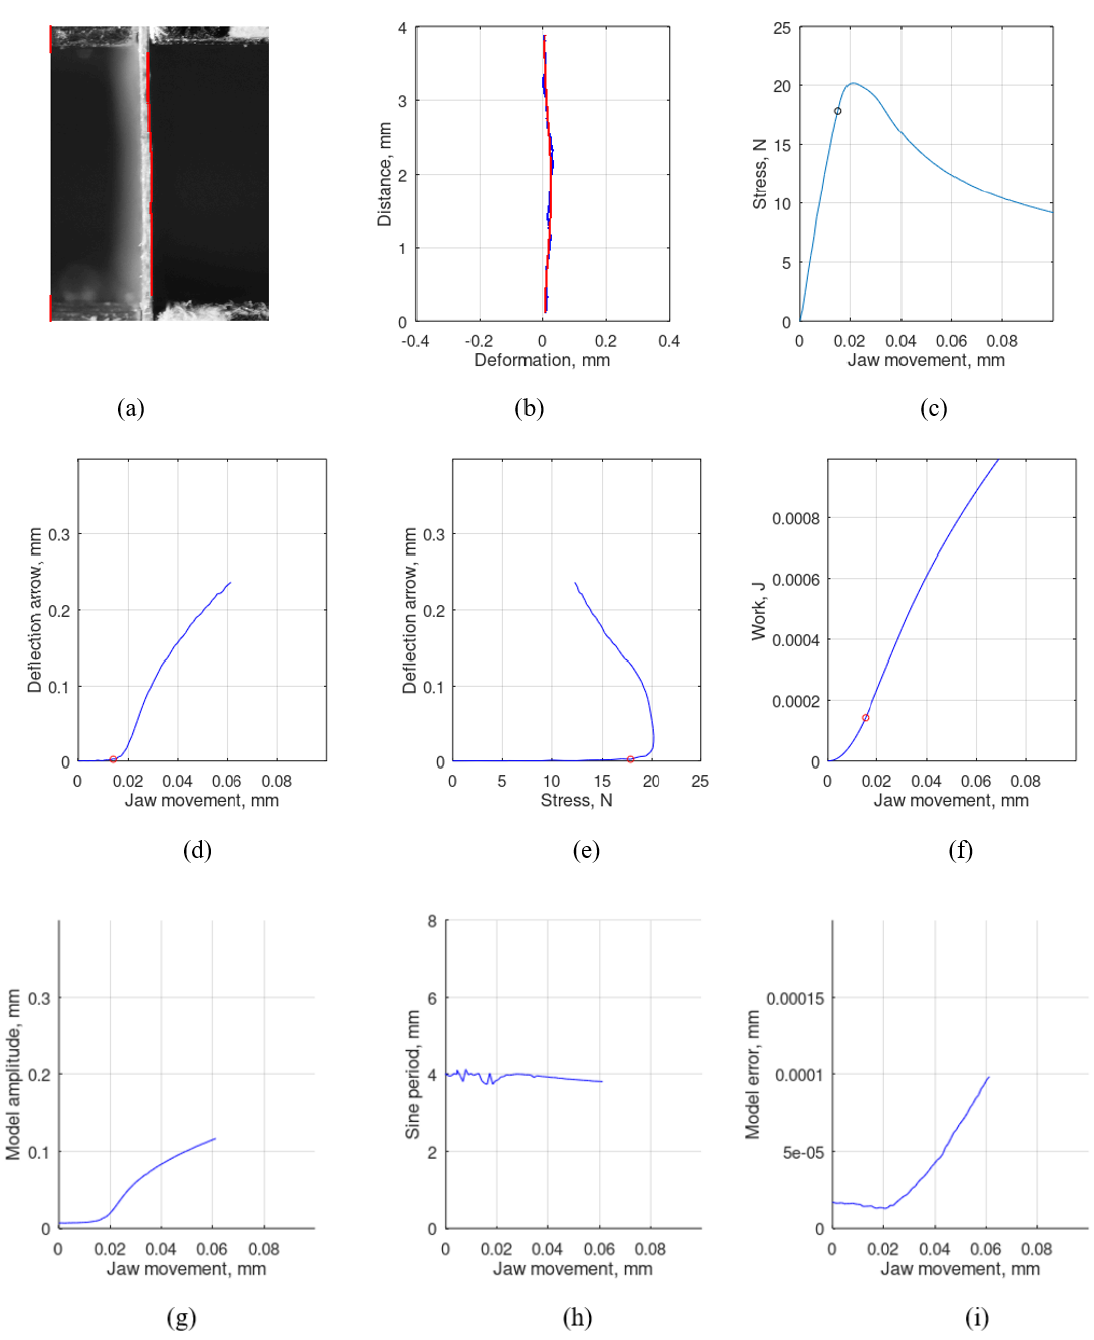
Figure 9. The results of compression analysis of a 4 mm long paper sample at the time of the appearance of the sample buckling.